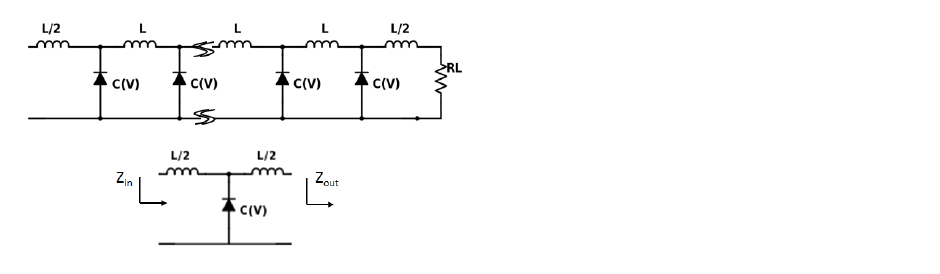
Figure 7. Equivalent circuit of multiple section NLTL and a single section NLTL with input and output